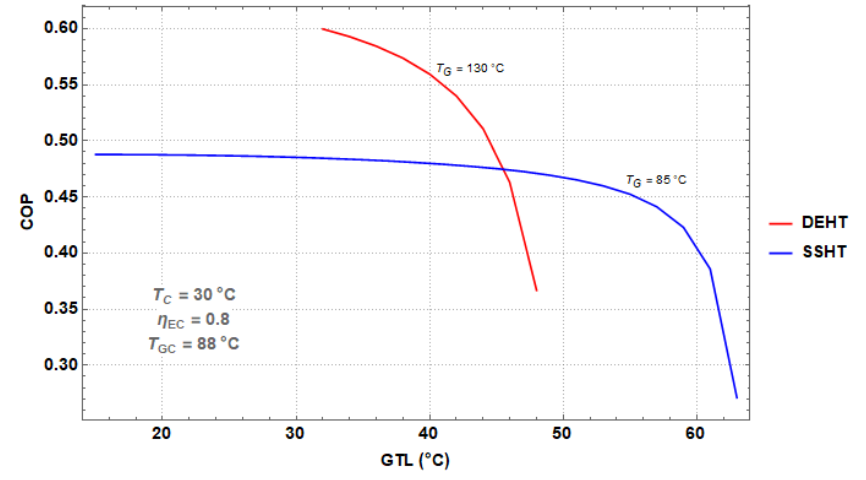
Figure 10. Comparison of the COP as a function of T G for the two different heat transformers.